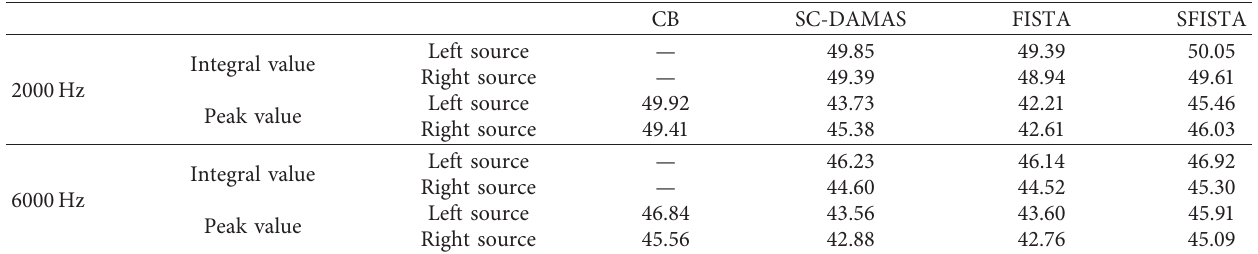
Figure 9: Experimental contour maps of SPLs at 1m distance from the source using different algorithms. (a) CB at 2000Hz; (b) SC-DAMAS at 2000Hz; (c) FISTA at 2000Hz; (d) SFISTA at 2000Hz; (e) CB at 6000Hz; (f) SC-DAMAS at 6000Hz; (g) FISTA at 6000Hz; (h) SFISTA at 6000Hz. Table 2: Experimental quantification results of different